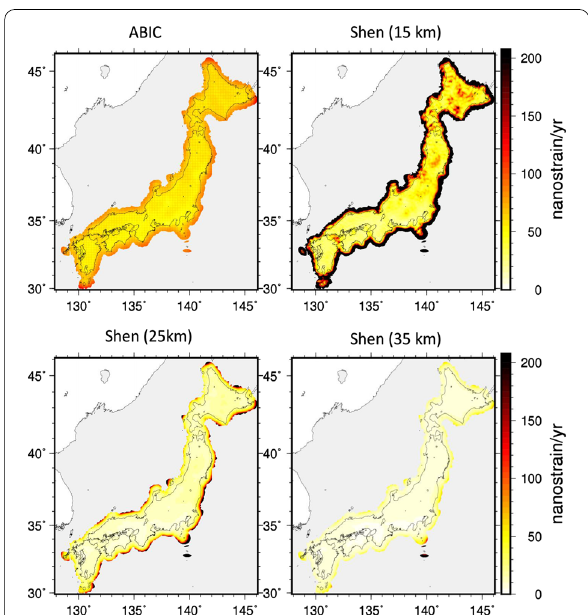
Fig. 13 Comparison of the estimation errors in terms of the absolute value of velocity vector. Results of different D values are presented for Shen’s method